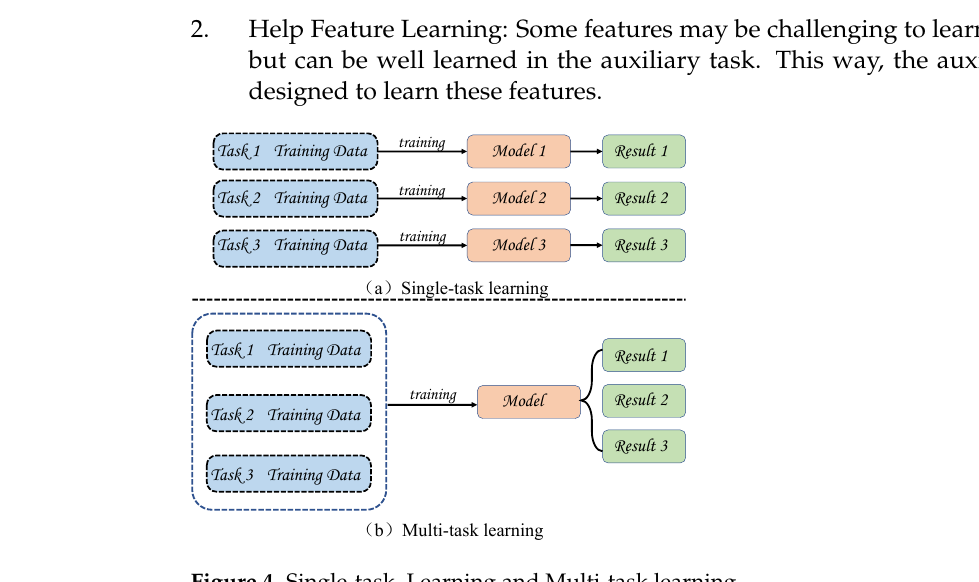
Figure 4. Single-task Learning and Multi-task learning.